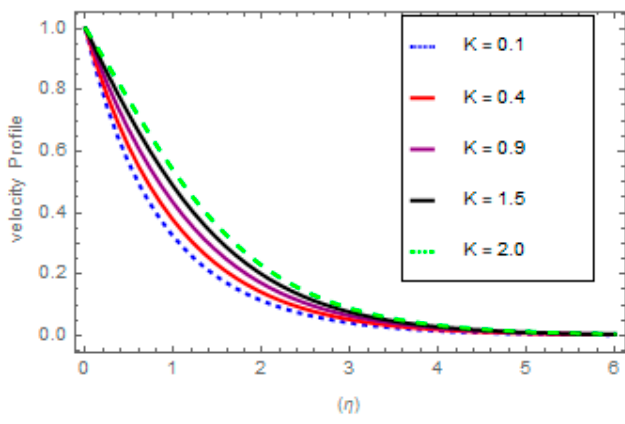
Figure 2. Upshot of β on u (cid:48)